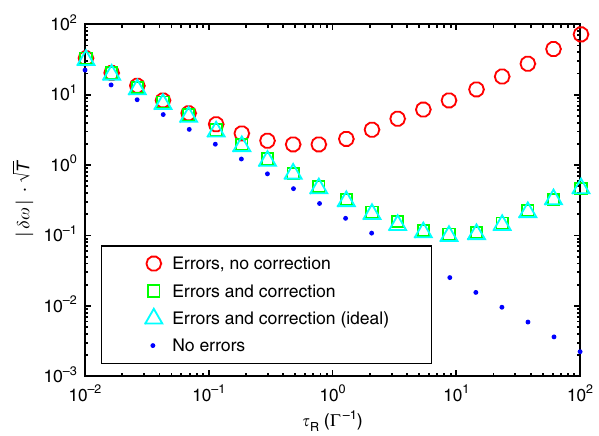
Fig. 7 Quantum error correction enhanced sensing. The plot shows the ffiffiffi p normalized measurement precision j δω j T vs. the Ramsey time τ R for a Ramsey measurement subject to spin- fl ips. The action of the error- correcting scheme can be seen to improve the achievable sensitivity by about an order of magnitude: The shown results display the normalized measurement precision assuming errors and (i) no error correction, (ii) error correction using the ideal jump operators given in Eq. (9), and (iii) error correction including undesired processes using the jump operators given in Eq. (22). As reference, the precision in the absence of errors (iv) is also shown. For the numerical simulation, we use G = 5000 Γ , where Γ is the spin- fl ip rate, and the optimized parameters Ω = 4 κ eng /5 and κ eng = 1.2 ( Γ G 2 ) 1/3 discussed in the text, and restrict the full master equation to